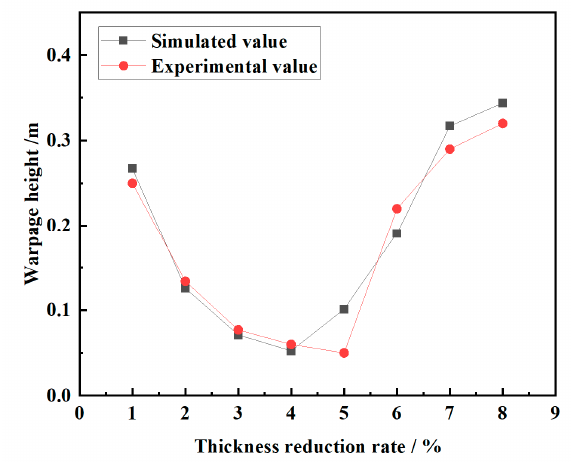
Figure 16. Comparison between measured and simulated head warpage values of the Ti/Steel clad plate after rolling.